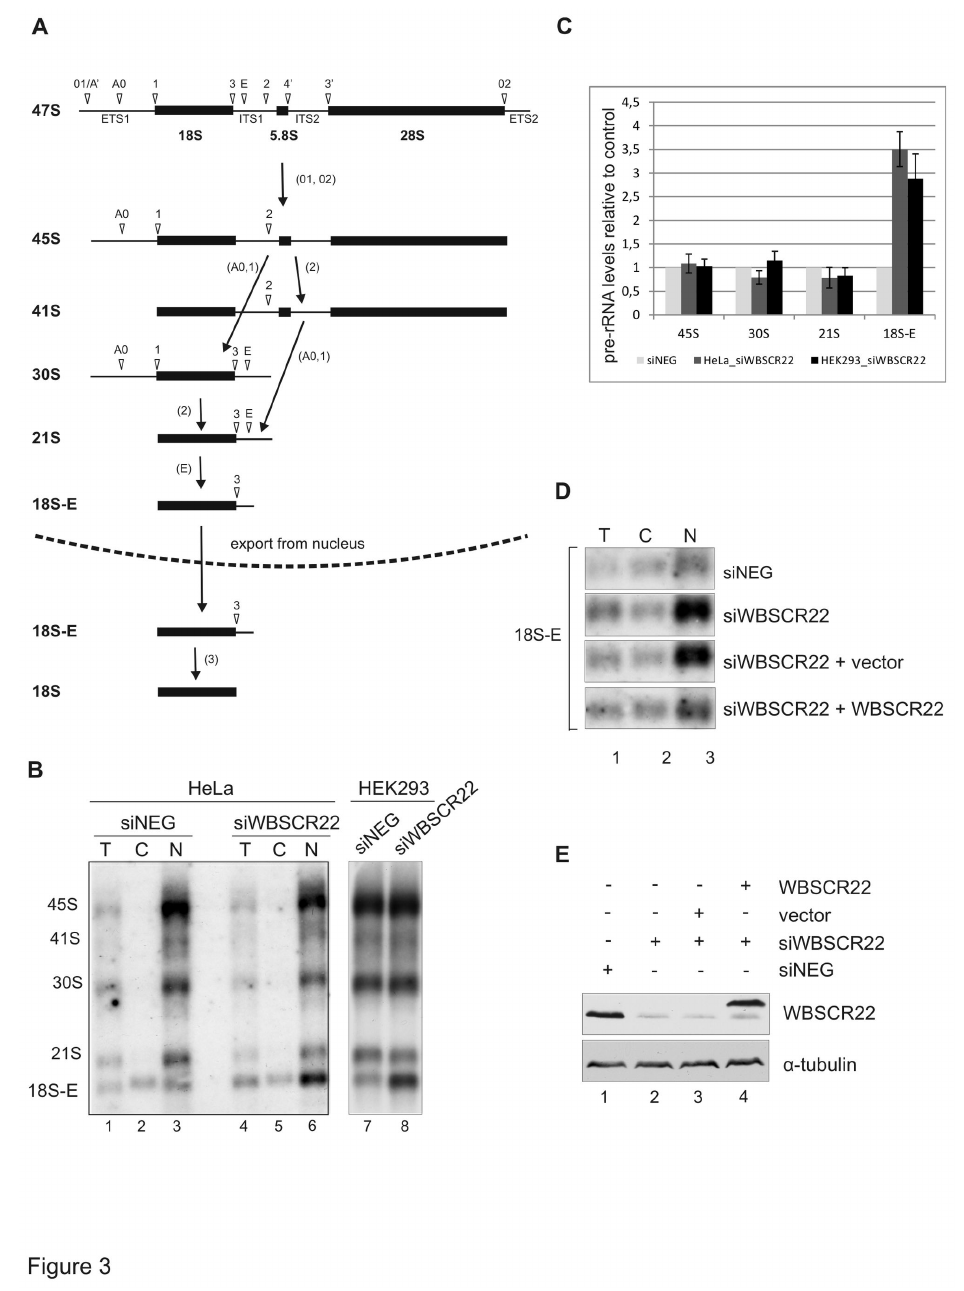
Figure 3. Analysis of pre-rRNA processing in WBSCR22-depleted cells. (A) Pre-rRNA processing in HeLa cells according to Carron et al. [19]. (B) Northern blot analysis of HeLa (lanes 1-6) and HEK293 (lanes 7, 8) cells transfected with siWBSCR22 or siNeg. with the 5’-ITS1 probe. RNA was extracted 72 h after transfection and 3 µg of total (T), 6 µg of cytoplasmic (C) and 3 µg of nuclear (N) RNA were loaded on each lane. Lanes 7 and 8 show nuclear RNA. The positions of precursor rRNAs are indicated. (C) The amounts of pre-rRNAs in the nuclear fractions of HeLa and HEK293 cells were quantified by PhosphorImager and are represented relative to siNeg of appropriate cell line which was set as 1. Results shown are representative of three independent transfection experiments with standard deviations. The P value is 0.2 for 21S and 0.02 for 18S-E using Student’s t-test. (D) Northern blot analysis of rRNA from T (total), C (cytoplasmic) and N (nuclear) fractions with the 5’-ITS1 probe from HeLa cells transfected with siWBSCR22 and plasmids expressing E2Tag-WBSCR22 or epitope tag alone. Band corresponding to 18S-E pre-rRNA is shown. (E) Protein expression of siWBSCR22-depleted cells transfected with expression plasmid for E2Tag-WBSCR22 was determined by western blotting using anti-WBSCR22 and anti-tubulin antibodies. doi: 10.1371/journal.pone.0075686.g003 PLOS ONE |